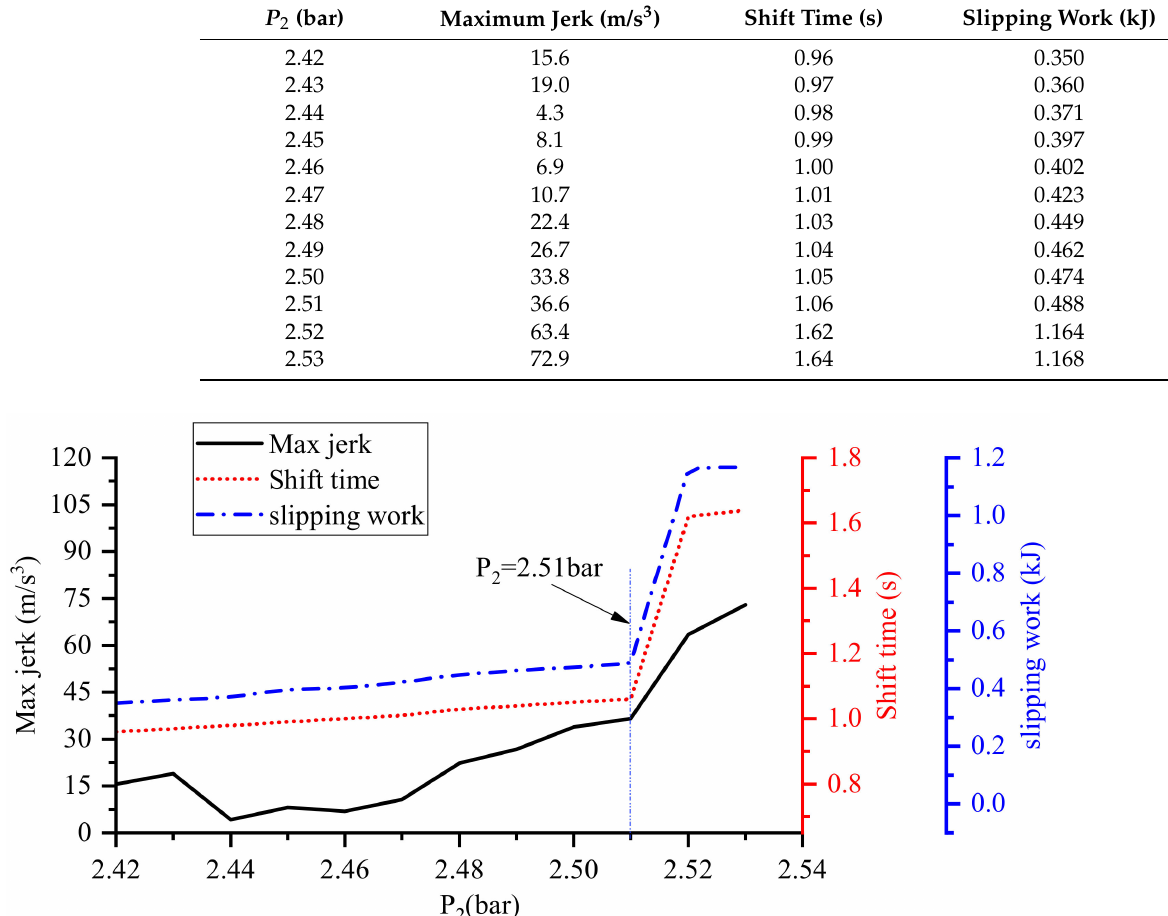
Figure 10. Variations of the shift evaluating indexes under different P 2